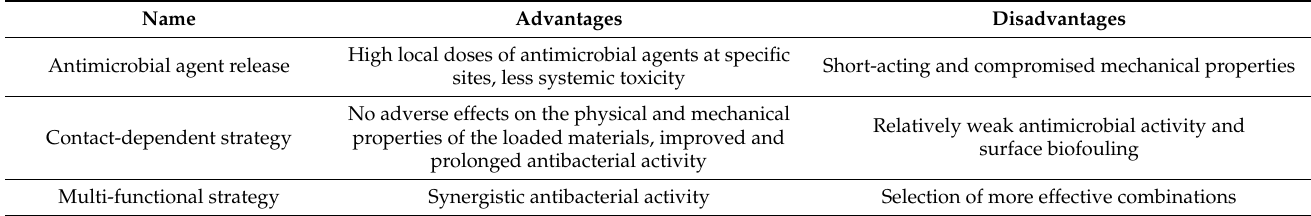
Table 1. Advantages and disadvantages of three antibacterial